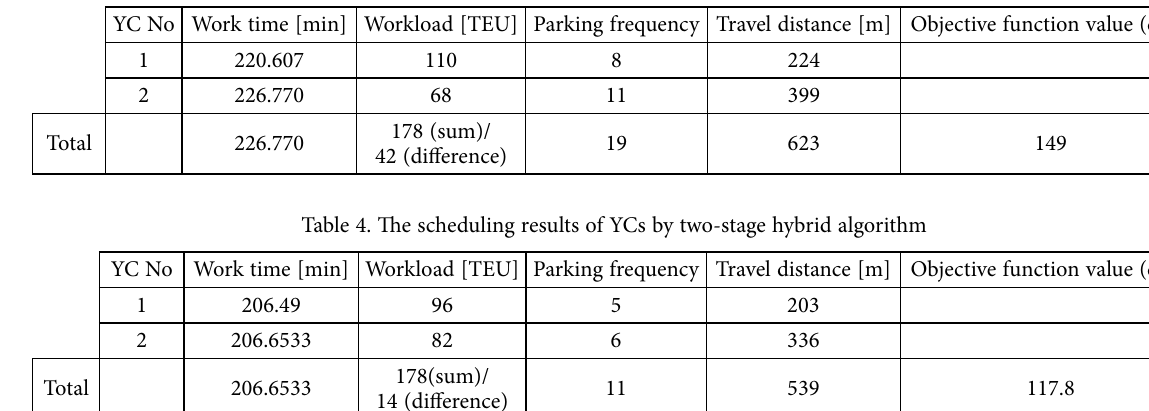
Table 3. The scheduling results of YCs by actual rules